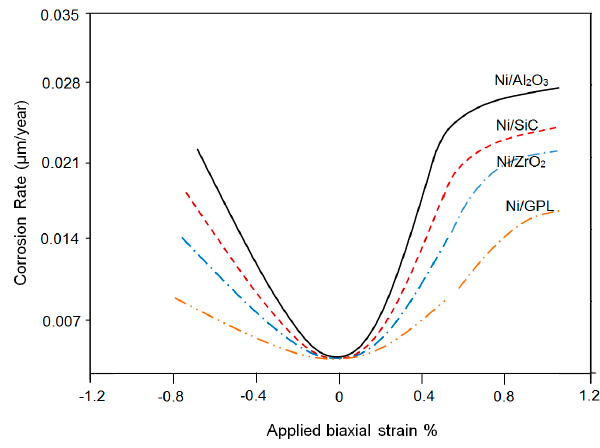
Figure 10. The corrosion rates of coatings as a function of applied biaxial strain.